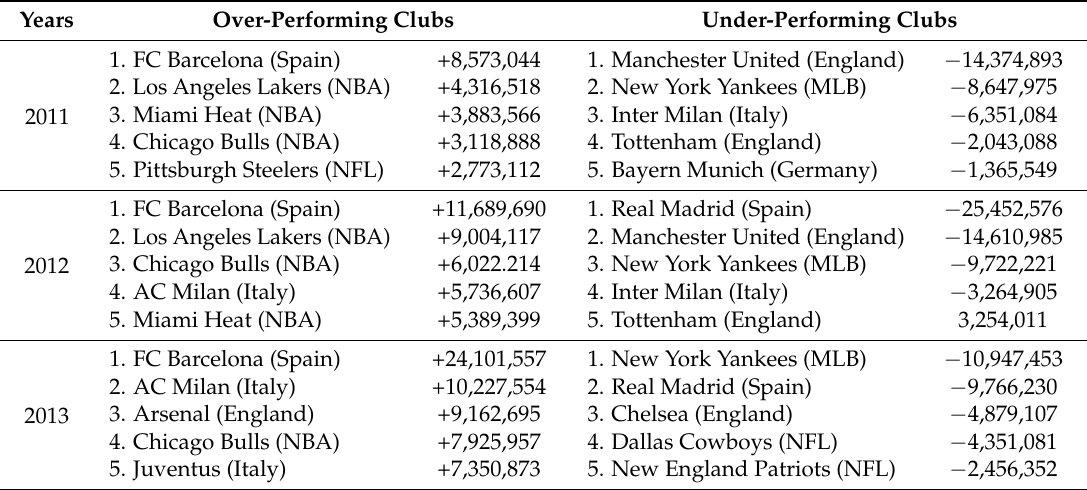
Table 3. Over- and under-performing clubs on Facebook in absolute values.